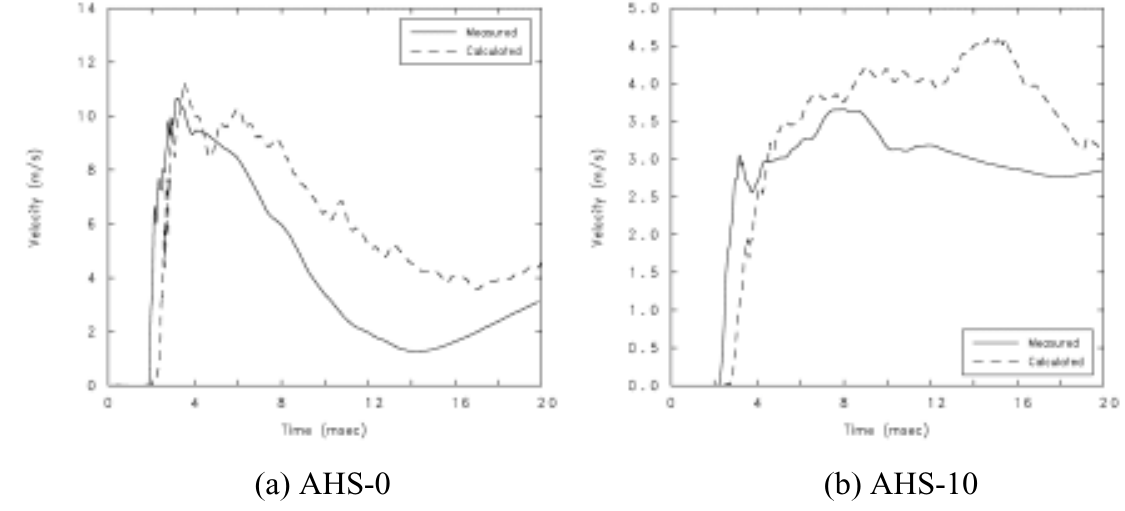
Fig. 8. Velocity at accelerometer locations AHS-0 and AHS-10, Test